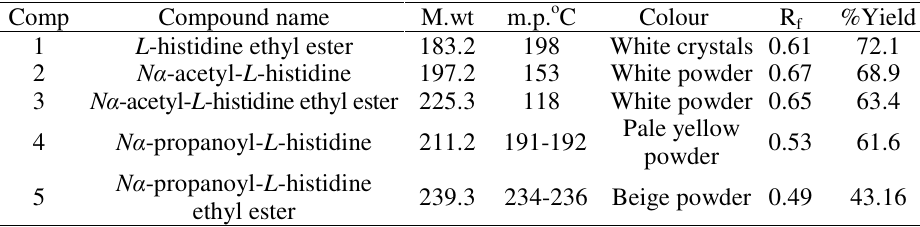
Table 1. Characterizations and physical data of histidine